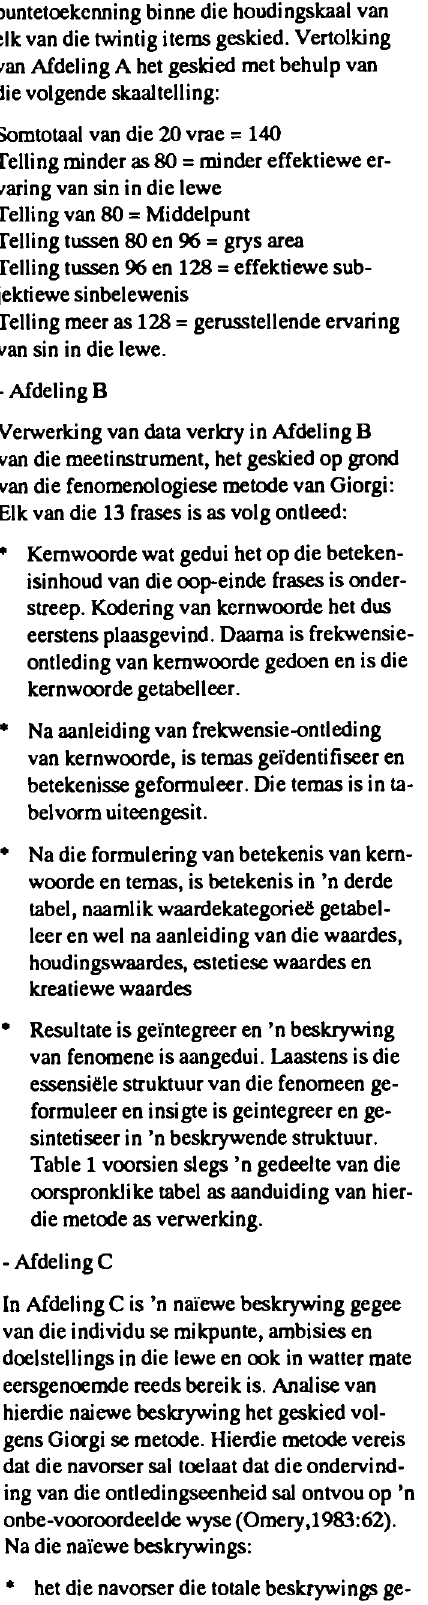
Table 1 voorsien slegs ’n gedeelte van die oorspronklike tabel as aanduiding van hier­ die metode as